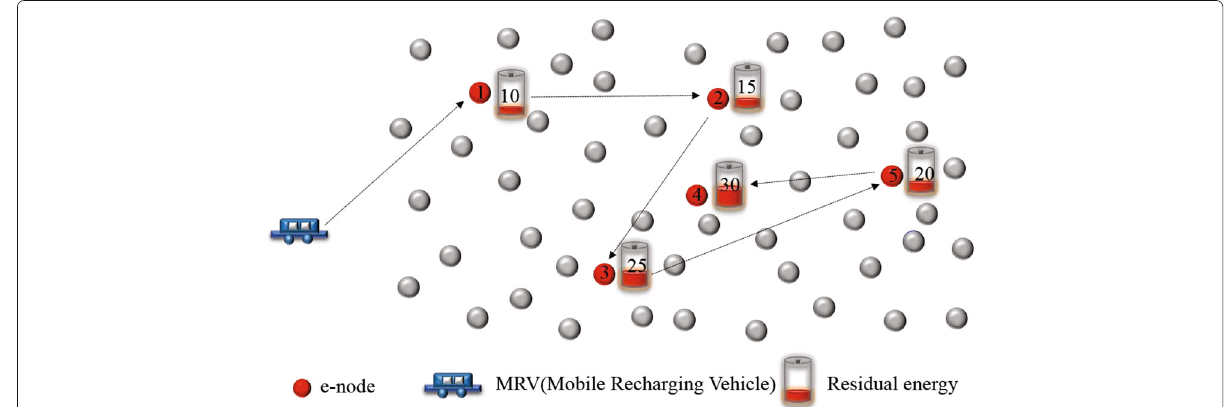
Fig. 1 Illustration of the problem only considering remaining energy of sensors